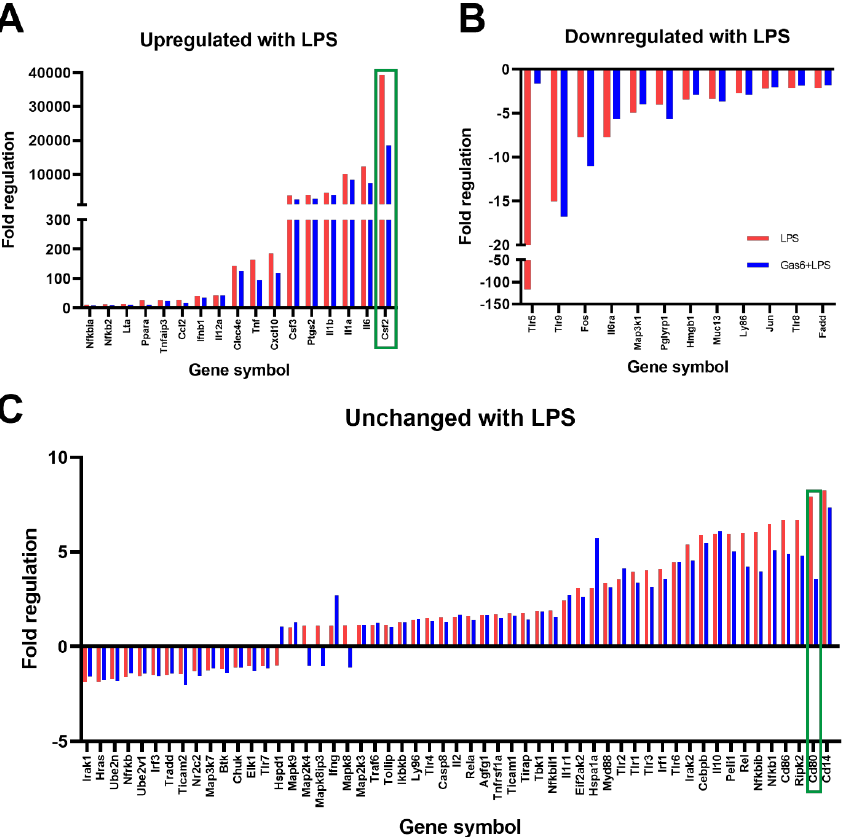
Figure 1. A TLR signalling gene array identified the Csf2 gene as markedly affected by Gas6/TAM signalling in microglial cells undergoing inflammatory stimulation. An RT 2 Profiler Gene Array for the TLR signalling pathway was used to measure the expression of 84 genes of interest in pure mouse microglial cultures. Microglia were treated with LPS (10 ng/mL; blue bars) for 8 h in the presence or absence of Gas6 co-incubation (1.6 µg/mL; red bars) added 1 h before and present thereafter. Results are presented as: ( A ) genes upregulated more than 10-fold after LPS stimulation, ( B ) genes downregulated more than 2-fold with LPS or ( C ) genes that were mostly unchanged with LPS treatment. Data is displayed as fold regulation (the negative inverse of fold change for values less than one) of gene expression and is from an exploratory experiment in one mouse culture. Green boxes highlight the genes for which Gas6 presence markedly altered the LPS-induced expression